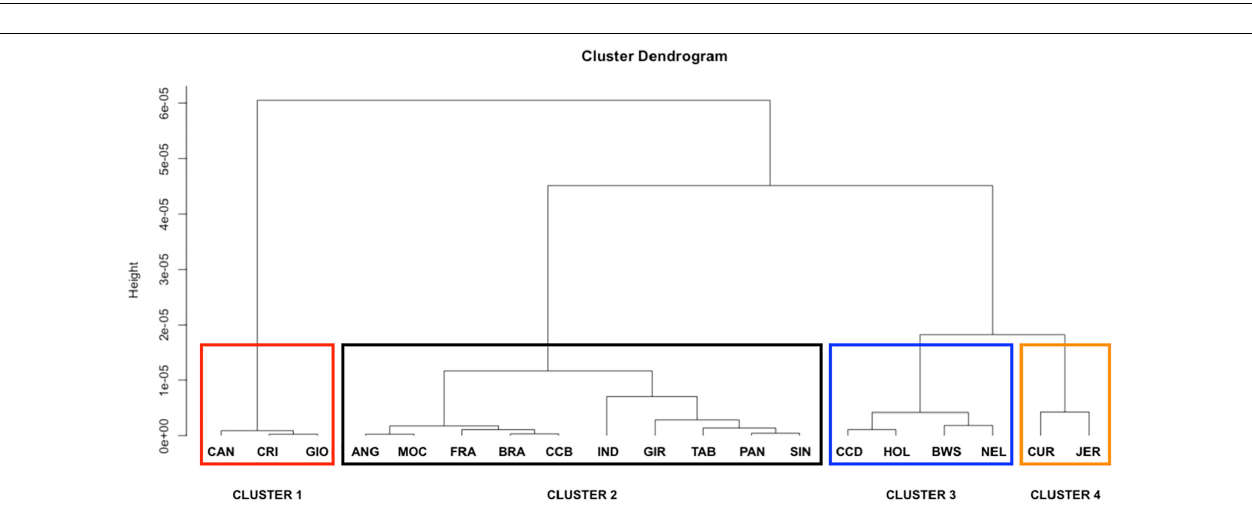
FIGURE 2 | Clustering of 19 cattle breeds raised in Brazil. Dendrogram showing population clusters based on LD decay using Euclidian distance and Ward’s aggregation method. ANG, Angus; BWS, Brown Swiss; JER, Jersey; HOL, Holstein; BRA, Brahman; GIR, Gir; IND, Indubrasil; NEL, Nelore; SIN, Sindhi; TAB, Tabapuã; CCD, Caracu Dairy; CCB, Caracu Beef; CRI, CriouloLageano; CUR, CurraleiroPé-Duro; FRA, CriouloLageano do RS; MOC, MochoNacional; PAN, Pantaneiro; CAN, Canchim; GIO, Girolando.